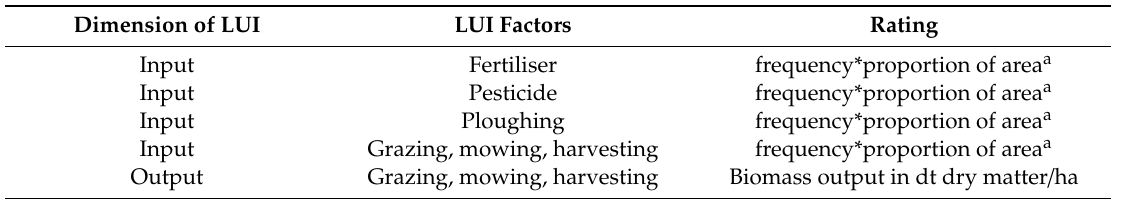
Table 2. Rating scheme of habitat